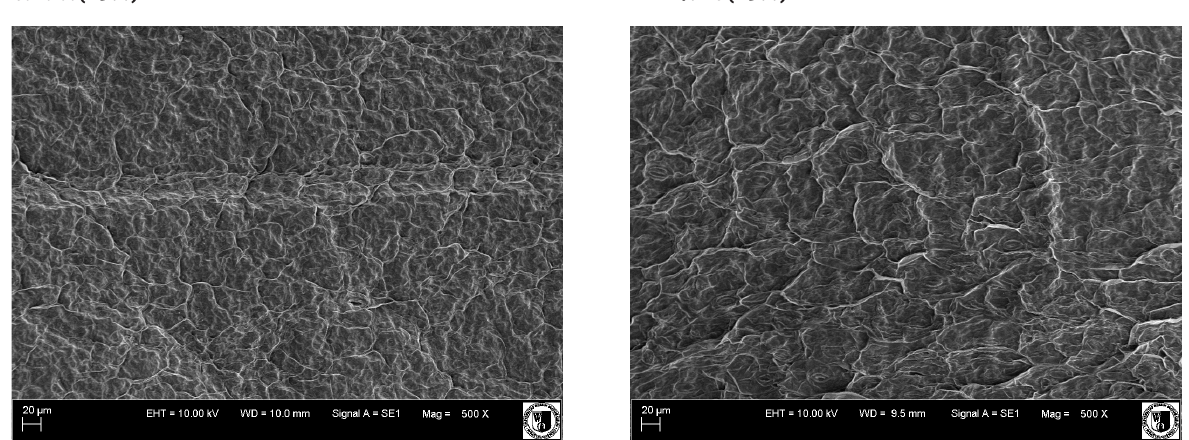
Figure 1: The influence of algal extracts produced by MAE on plant morphology: (a) stalk, (b) leaf – internal part, (c) leaf – external part of